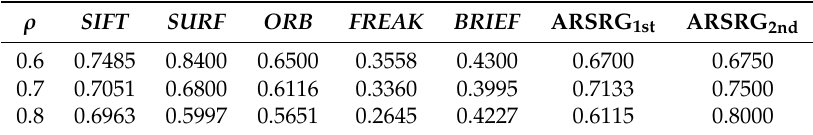
Table 1. Quantitative comparison using the Mean Reciprocal Rank (MRR) measure among SIFT [8], SURF [29], ORB [30], FREAK [31], BRIEF [32], and the Attributed Relational SIFT-based Regions Graph (ARSRG) matching on the dataset in [26].